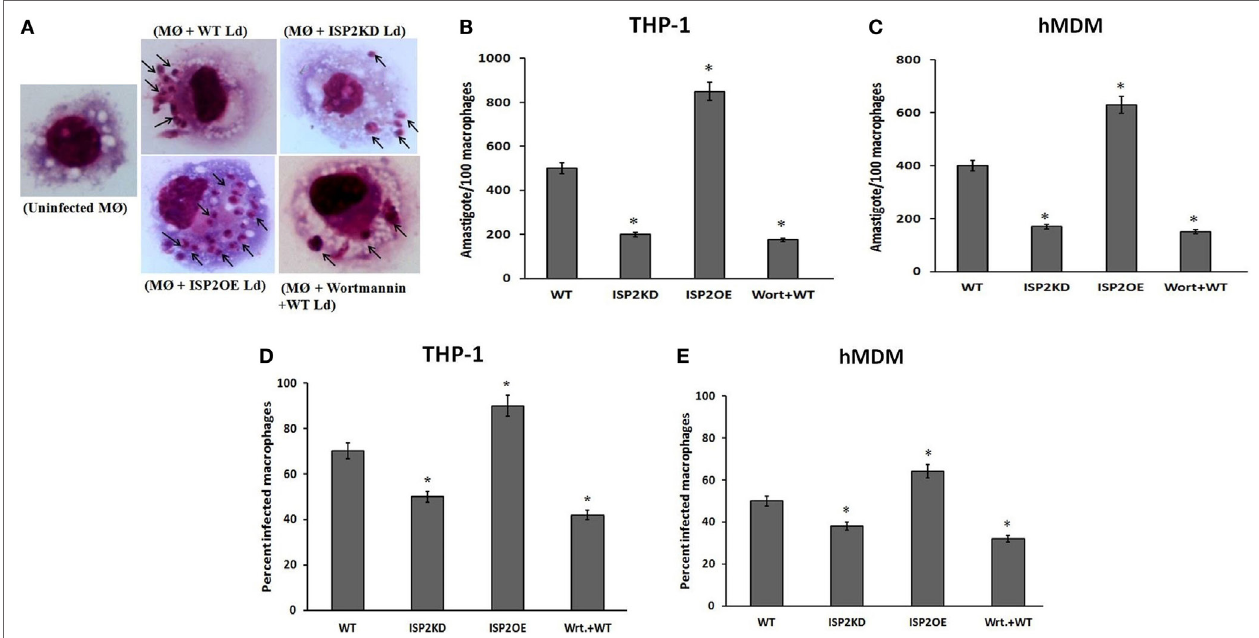
FigUre 10 | Effect of LdISP2 on survival of Leishmania donovani inside macrophages. THP1 monocyte-derived macrophages and human monocyte-derived macrophages (hMDM) were either left untreated or pretreated with wortmannin followed by infection with WT, ISP2KD and ISP2OE Leishmania parasites for 24 h. After infection intracellular parasites inside the macrophages (THP1) were visualized by staining the cells with Giemsa followed by optical microscopy at 100 × oil immersion (a) . The parasite load inside THP1 cells (B) and hMDM cells (c) was measured by counting the number of intracellular amastigotes per 100 macrophages. The rate of infection was analyzed by counting the percent infected macrophages [THP1 and hMDM (D,e) ]. Each determination was made in triplicate and the values were expressed as mean ± SD for three independent experiments. A Student’s t -test was used to evaluate statistical significance; Asterisk (*) denotes P < 0.05 whereas, “ns” denotes non-significant change. Abbreviations: WT, wild-type; Wrt + WT, Wortmannin-treated macrophages infected with wild type; ISP2OE, ISP2 overexpressed; ISP2KD, ISP2 knocked down; MØ + WT Ld, Macrophages infected with WT Ld; MØ + ISP2KD Ld, Macrophages infected with ISP2 knocked down Ld; MØ + ISP2OE-Ld, Macrophages infected with ISP2 overexpressed